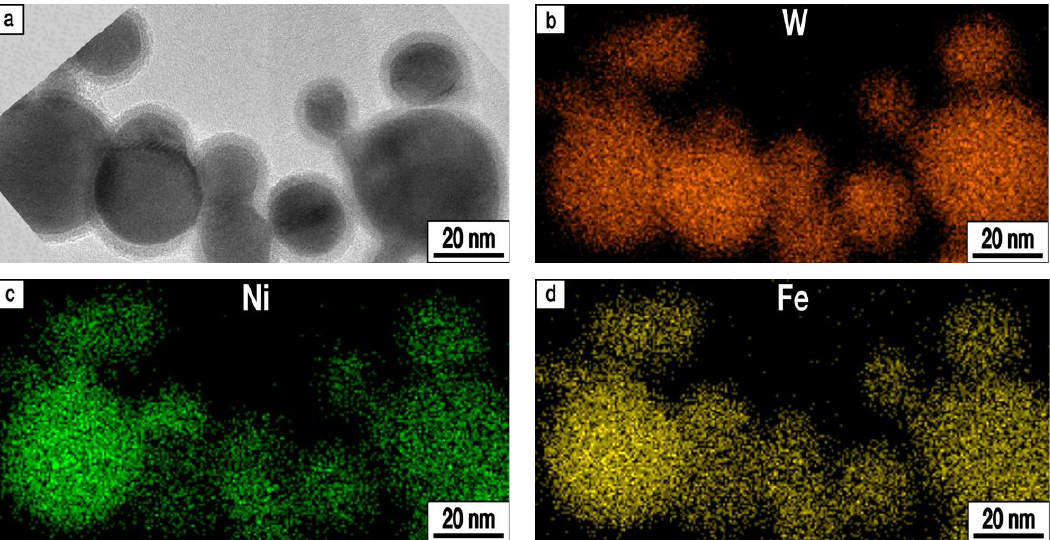
Figure 2. S TEM image ( a ) and maps of chemical elements distribution (EDS) ( b – d ) of W-5Ni-2Fe nanopowder.